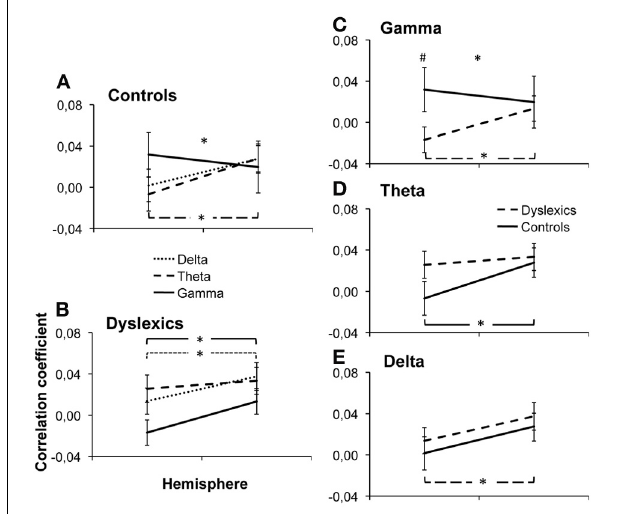
FIGURE 2 | Group × Frequency × Hemisphere interaction. Individual beta values were averaged over ROIs and plotted along the different dimensions of the interaction: Frequency × Hemisphere interaction in controls (A) and dyslexics (B) and Frequency × Group interaction in the gamma (C) , delta (D) and theta (E) bands. Error bars represent the s.e.m. ∗ indicates a significant interaction or difference with p < 0 . 05. # indicates a marginally significant difference, p = 0 .